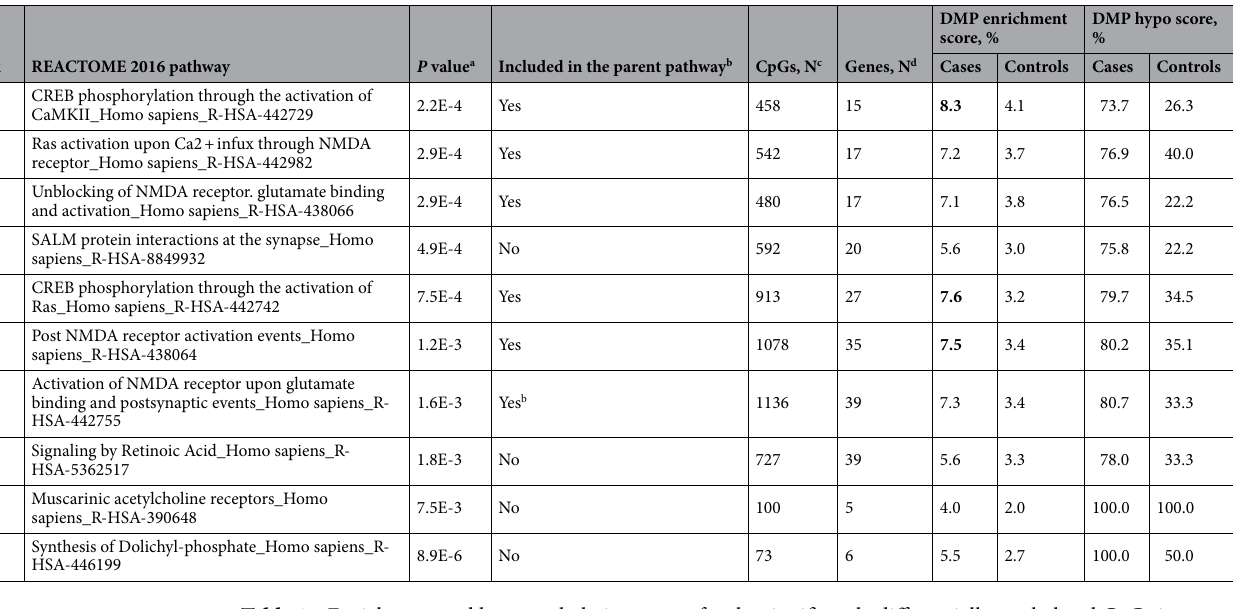
Table 1. Enrichment and hypomethylation scores for the significantly differentially methylated CpG sites (DMPs) in the top ten ranked Reactome 2016 pathways. a P value is unadjusted P value estimated by Enrichr from analysis of Top 30 genes. b Parent Pathway: “Activation of NMDA receptor upon glutamate binding and postsynaptic events_Homo sapiens_R-HSA-442755”. c Number of all 450 K Illumina CpGs corresponding to the genes enlisted for the pathway. d Number of genes enlisted for this pathway in Reactome 2016